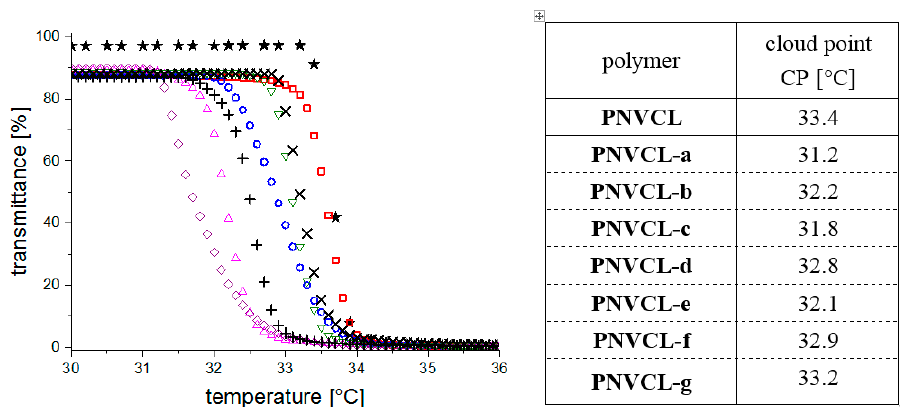
Figure 4. Temperature dependent turbidimetric analysis of PNVCL and dye-labeled NVCL copolymers in aqueous solutions (3.00 g·L − 1 , heating rate 0.2 K·min − ). ( ) = PNVCL , ( ) = PNVCL-a, ( o ) = PNVCL-b, ( Δ ) = PNVCL-c, ( ∇ ) = PNVCL-d, ( ) = PNVCL-e, ( ) = PNVCL-f, ( ) = PNVCL-g . The phase transition temperatures were taken as the temperature of the onset of clouding (cloud points CP).